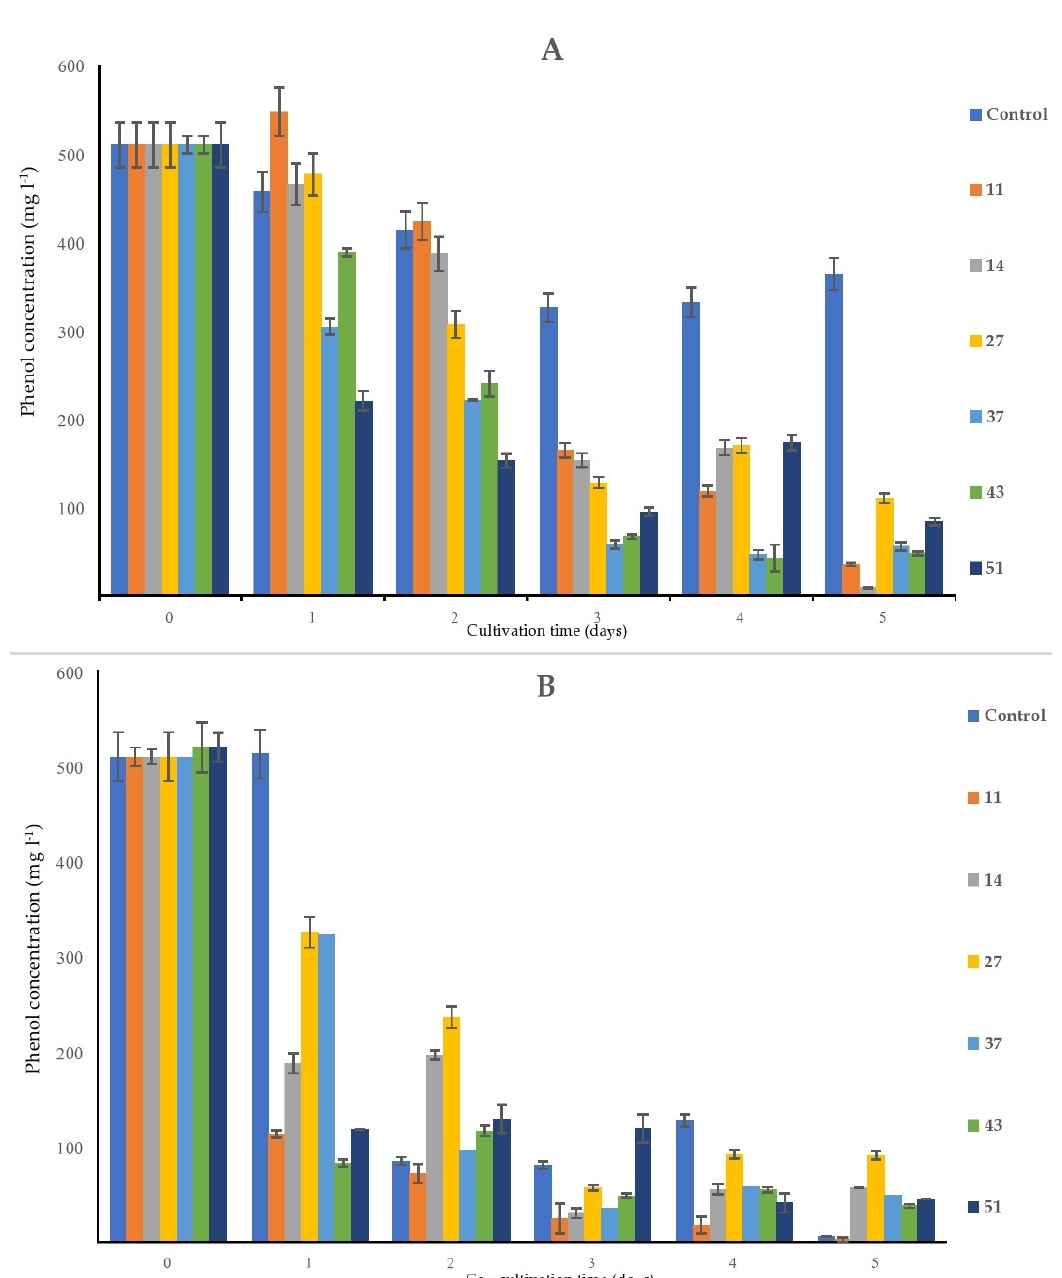
Figure 7. Removal of the initial phenol (500 mg L − 1 ) by the bacterial strains alone ( A ) and by bacteria and duckweed combined ( B ). Negative control is ( A ) a sterile MS solution with phenol; ( B ) sterile duckweeds in an MS solution with phenol. Numbers in the legend represent bacterial strains used in the experiment: 9— K. oxytoca , 11— Lelliottia sp., 14— K. oxytoca , 27— S. marcescens , 37— H. alvei , 43— H. paralvei , 51— S. nematodiphila . Data represent the mean ± SE ( n = 3).